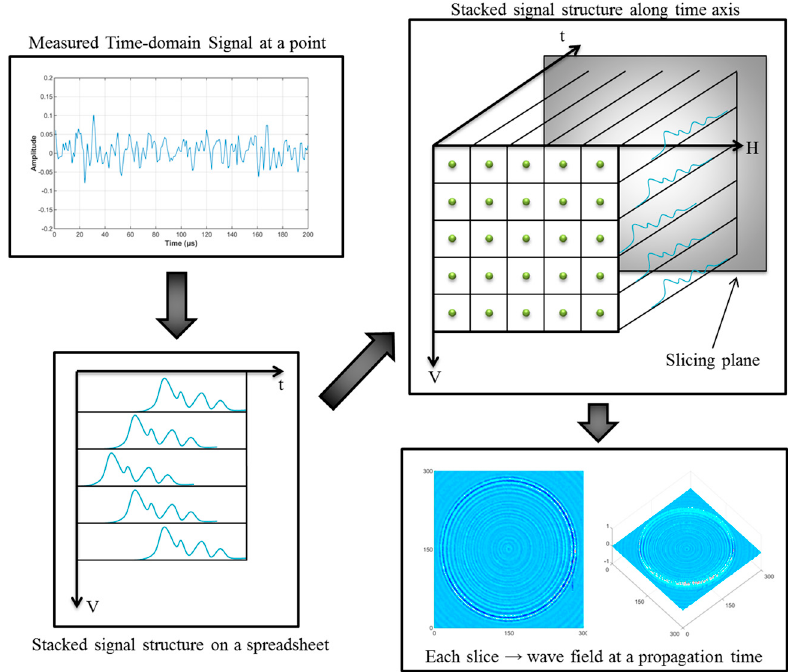
Figure 2. Process of the UWPI system.